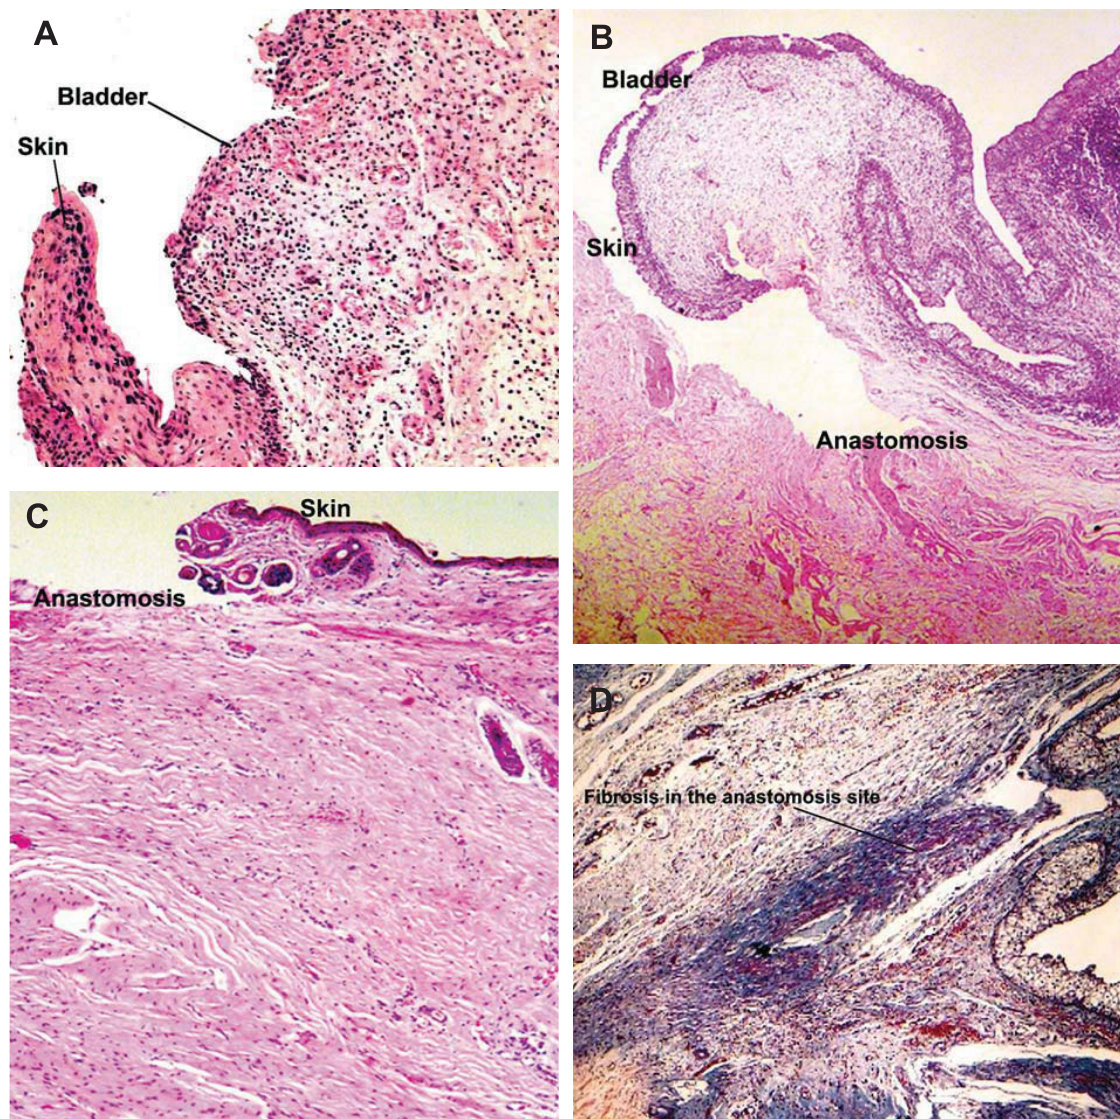
Figure 6 – Histological analysis of the specimen showed good integration of the skin tube with the bladder, in some areas with loss of epithelium however without